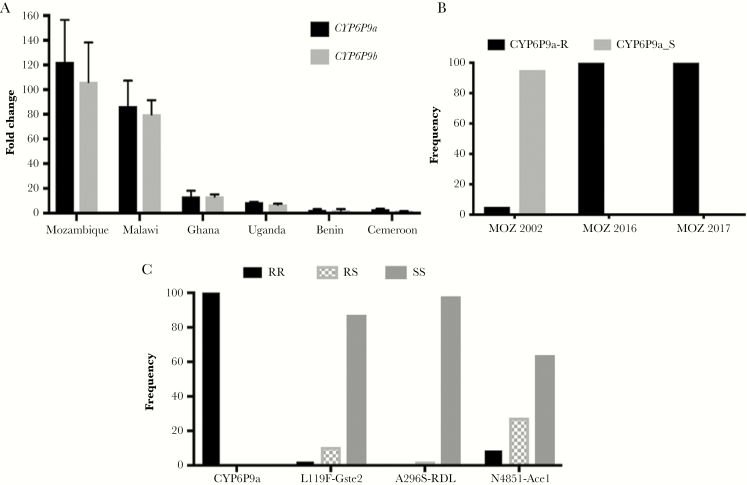
Exploration of the molecular basis of the escalation of pyrethroid resistance in Anopheles funestus. A, Comparative gene expression of the cytochrome P450 genes CYP6P9a and CYP6P9b in Mozambique comparatively to other African regions. Error bars represent standard error of the mean. B, Allele frequency of the CYP6P9a pyrethroid resistance marker in southern Mozambique populations from 2002, 2016, and 2017, showing a fixation of the CYP6P9a_R allele. C, Distribution of the genotypes of resistance markers in Palmeira including CYP6P9a_R, L119F-GSTe2, N485I-Ace-1, and A296S-RDL. Abbreviations: CYP, cytochrome P450; MOZ, Mozambique.